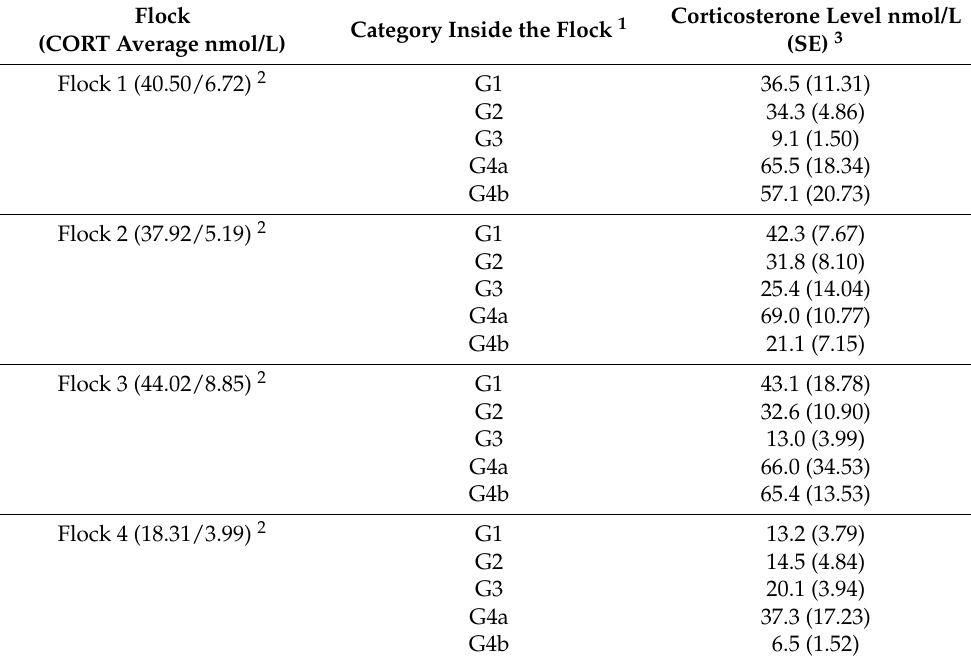
Table 4. Serum CORT levels in different groups of pigeons are presented separately by individ- ual flocks.